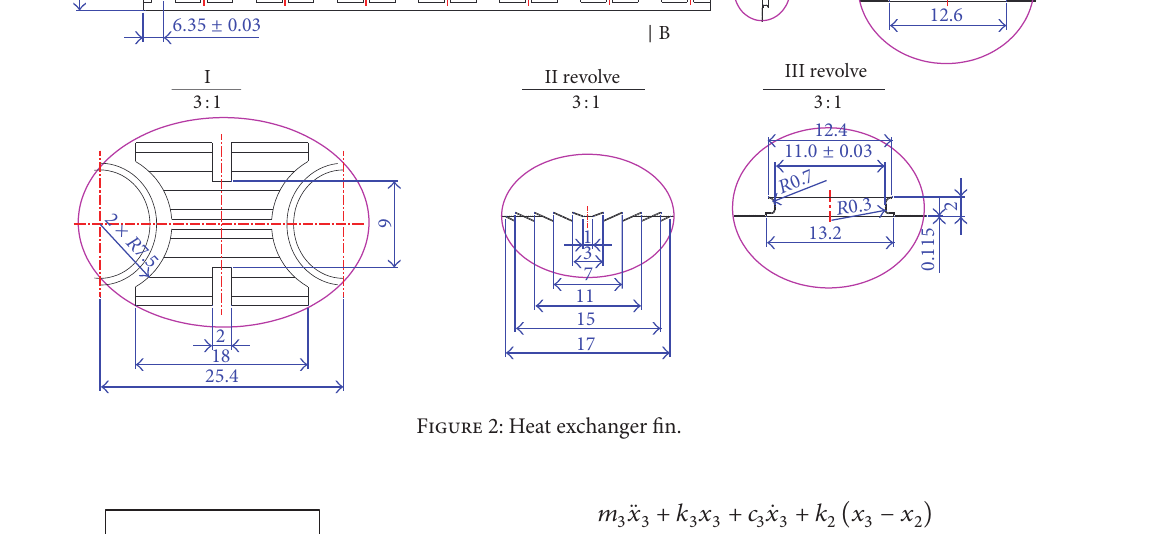
Figure 2: Heat exchanger fin.